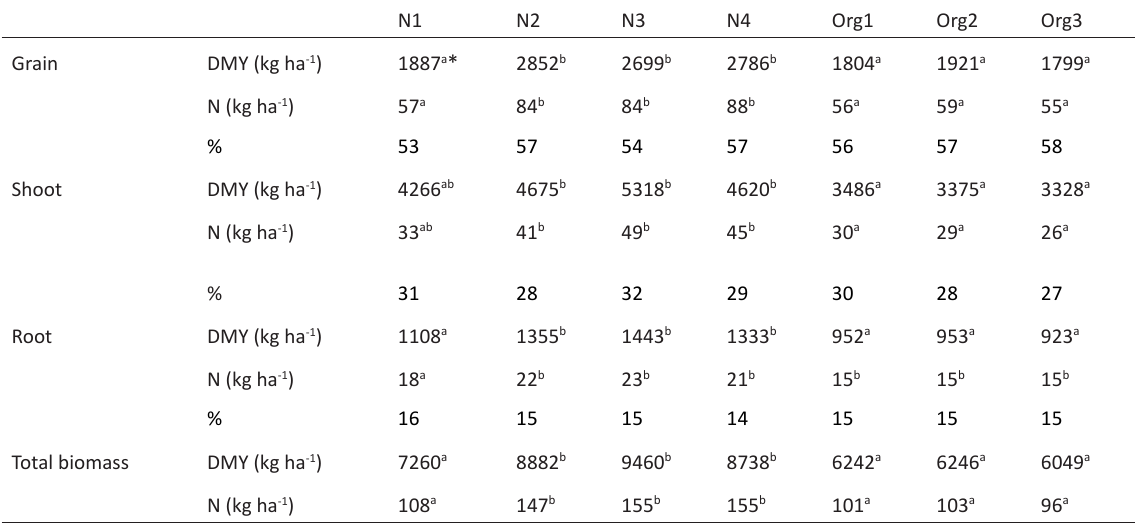
Table 4. Dry matter yield (DMY), nitrogen (N) accumulation by field pea and proportions of N accumulated in pea parts in different cropping systems (average of